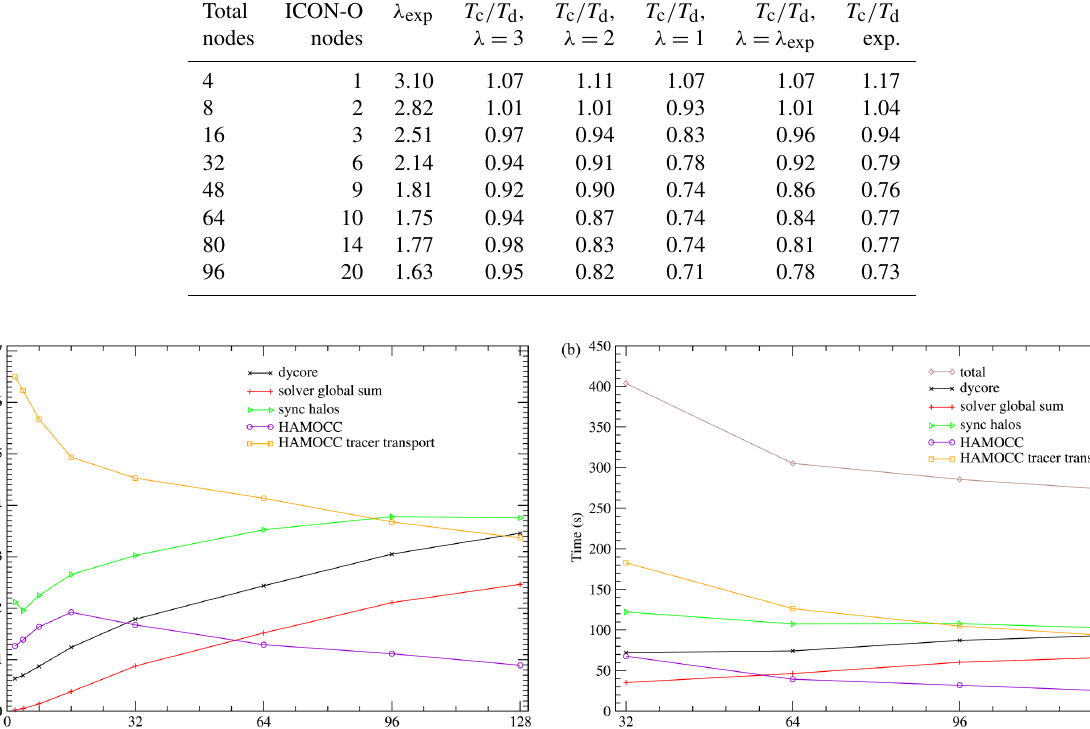
Figure 13. (a) Relative costs of the ICON-O–HAMOCC components in the sequential 40km setup. (b) Run times for each component.